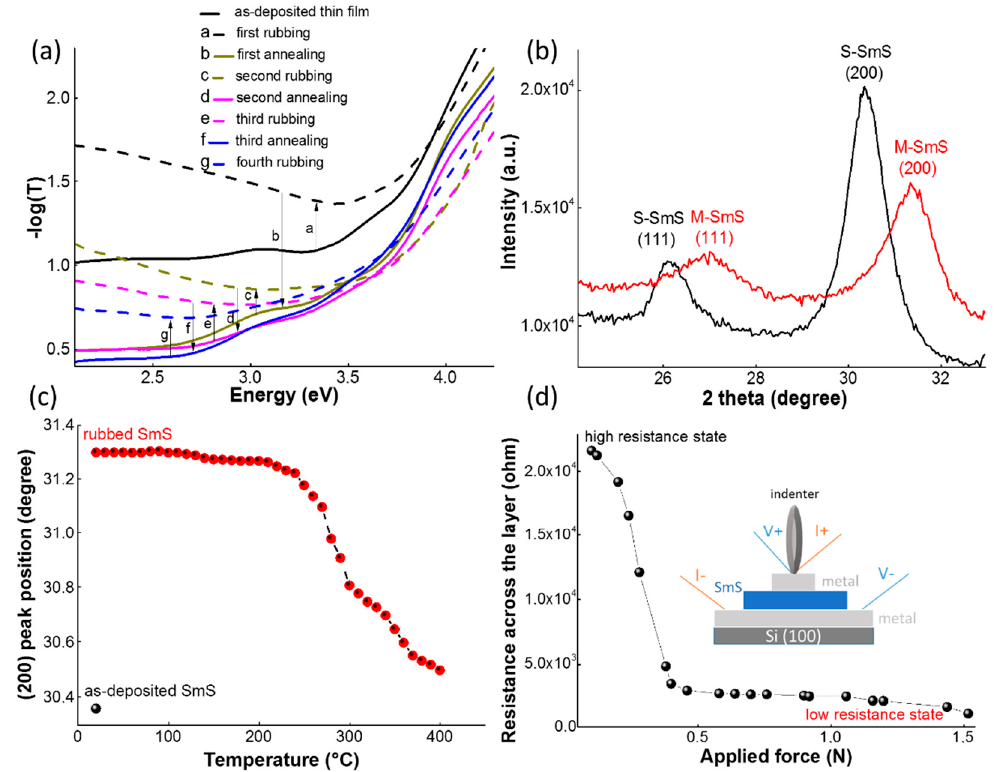
Figure 1. Optical, structural and electrical properties of samarium monosulfide (SmS) thin films in the semiconducting and metallic state. ( a ) Optical spectrum (T = transmission) of a 100 nm SmS thin film, which shows the repeated switching behavior between the semiconducting and metallic state. ( b ) XRD patterns of the semiconducting (black curve) and the pressure-induced metallic (red) state. ( c ) Position of the (200) di ff raction peak, measured with the in situ high temperature X-ray di ff raction (HTXRD) setup (10 ◦ C per step), when thermally annealing in O 2 a metallic SmS thin film. The black dot corresponds to the as-deposited semiconducting state SmS (S-SmS) thin film, for comparison. ( d ) Pressure-induced resistance change upon application of pressure by the indenter for a thin film stack of Al (50 nm) / SmS (100 nm) / Al (50 nm). The inset figure shows a sketch of the used measurement